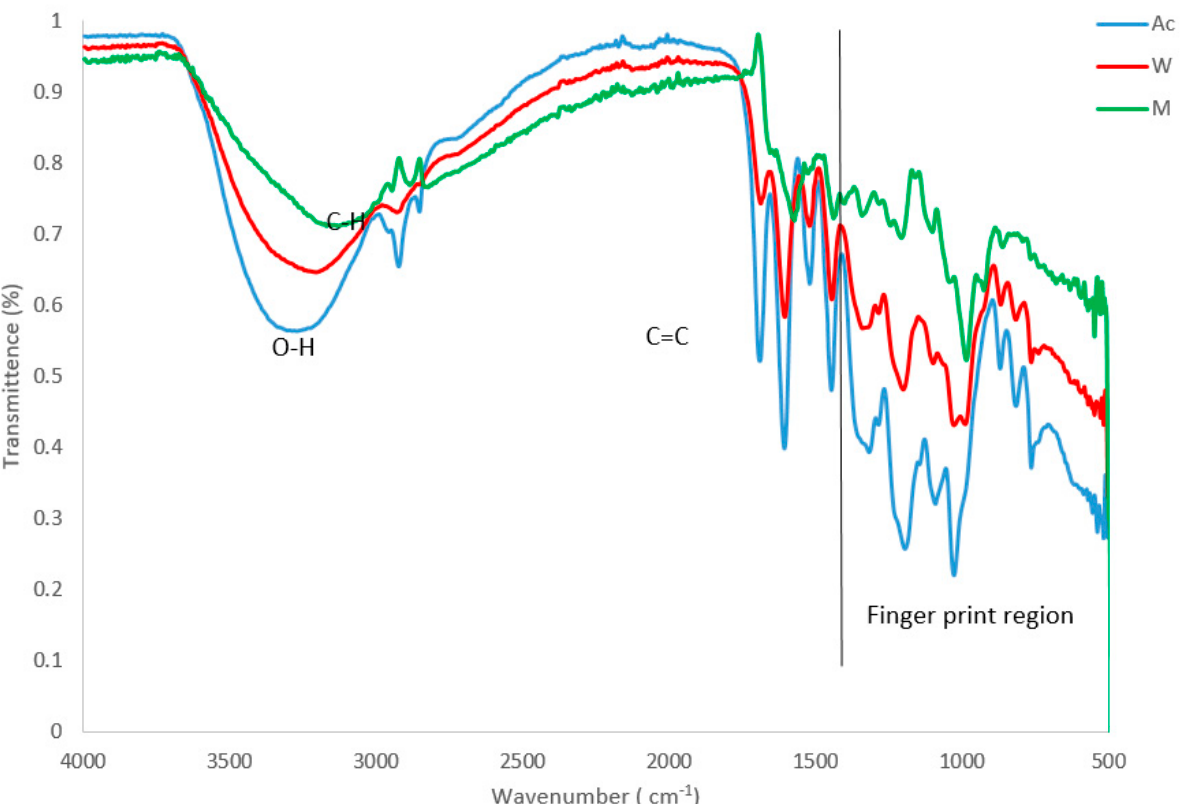
Figure 3. FTIR spectrum of P. grandiflora tubers extract prepared using different solvent where: Ac = acetone extract, W = water extract, and M = methanol extract.